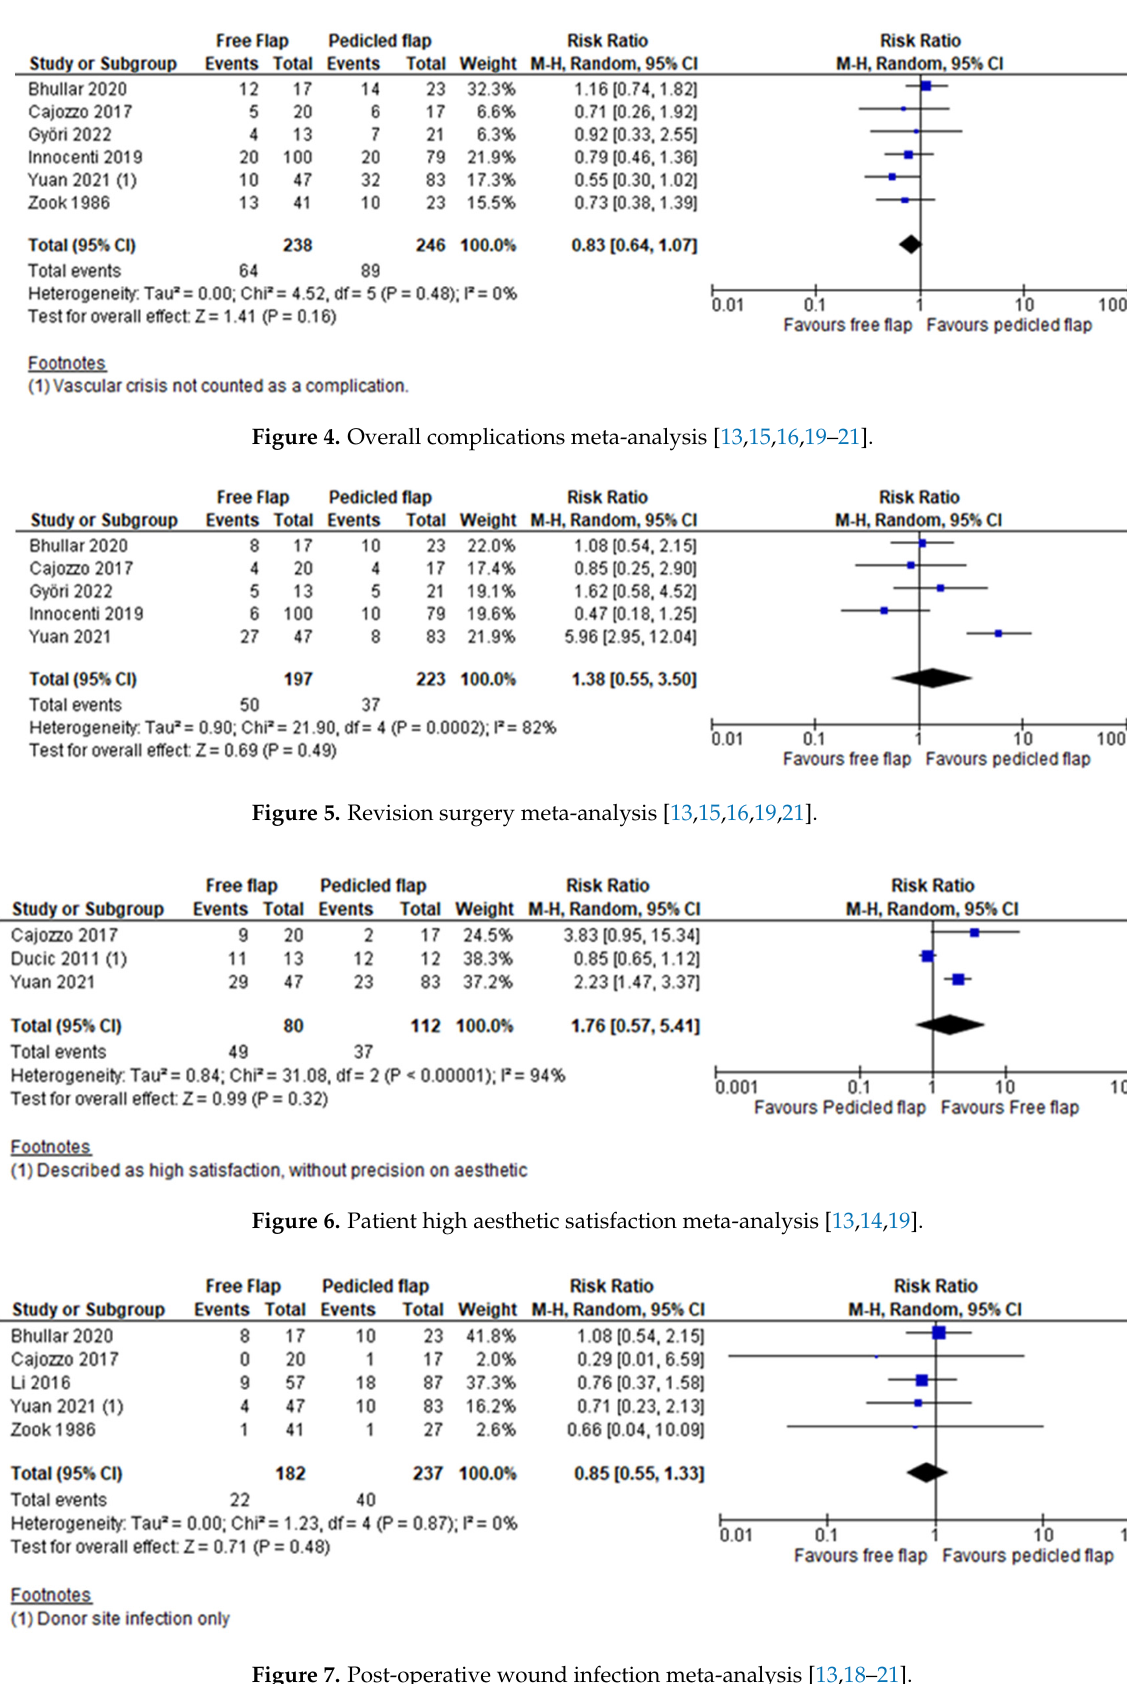
Figure 3. Partial flap necrosis meta-analysis [12–16,18–20].